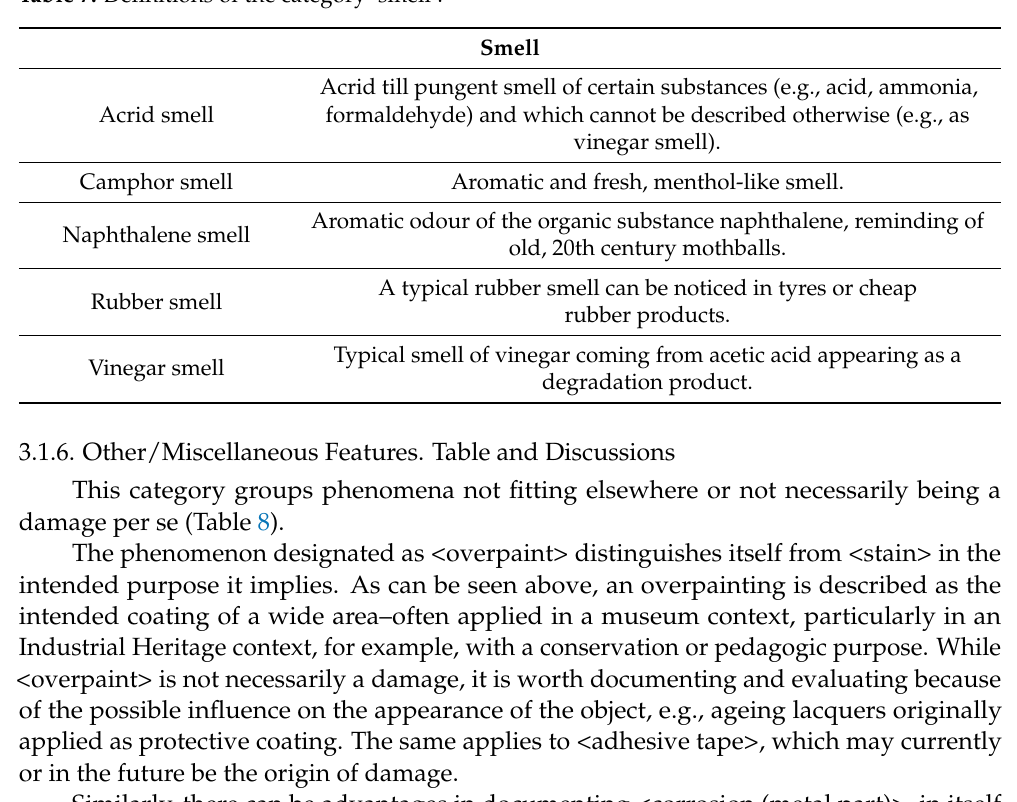
Table 7. Definitions of the category